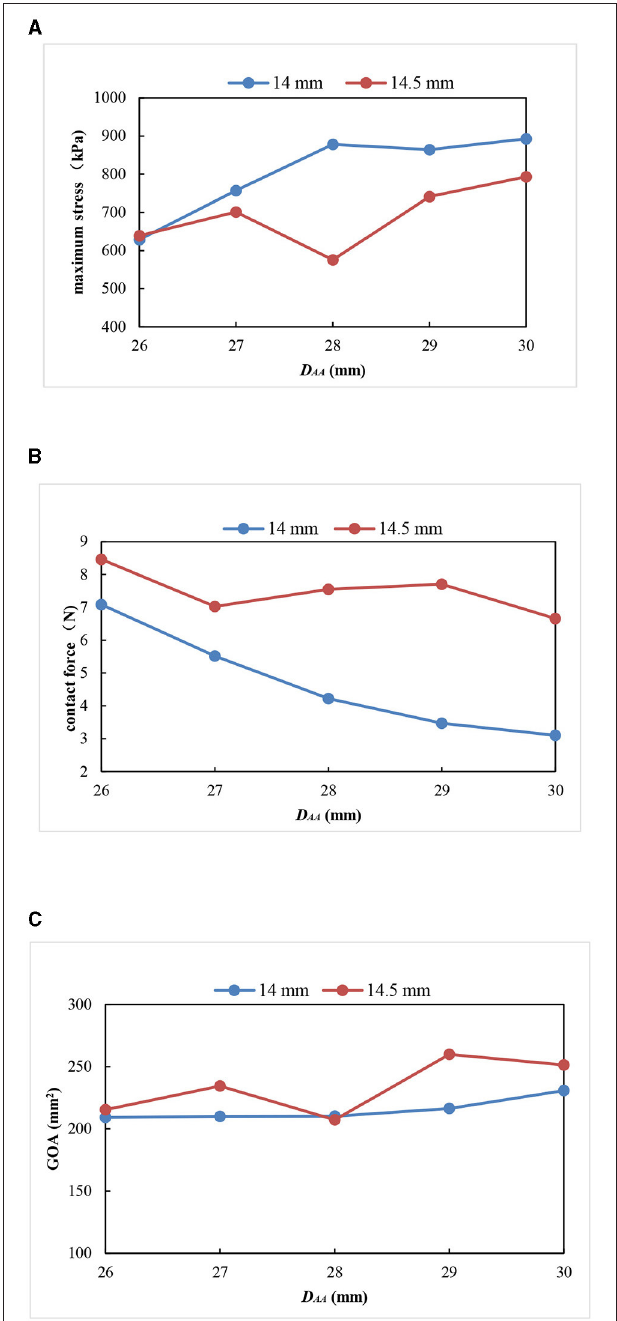
FIGURE 9 | Comparison of three parameters between the models with an H V of 14 and 14.5mm. (A) Maximum stress; (B) contact force; (C) geometric orifice area.